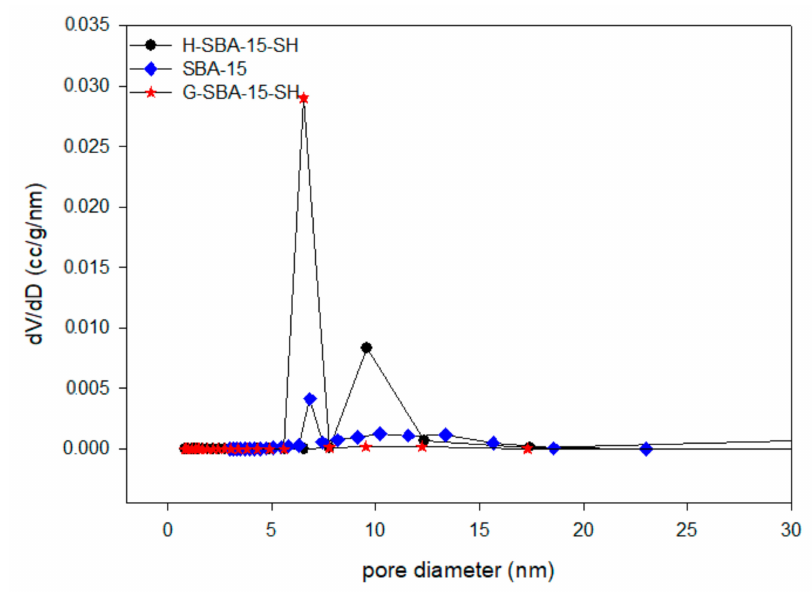
Figure 3. Pore size distributions of mesoporous SBA-15, H-SBA-15-SH,